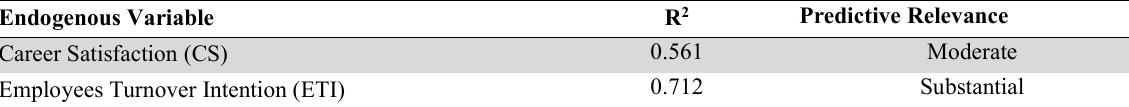
The R² Values for The Endogenous Latent Variables